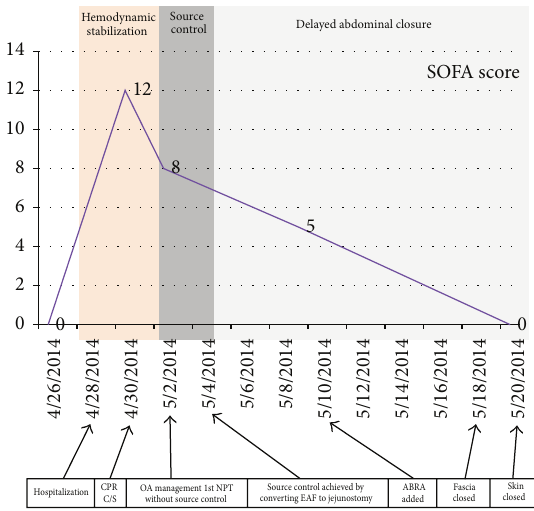
Figure 3: All the important interventions are given on the scale and change in the SOFA score according to these interventions from hospitalization to closure of OA.